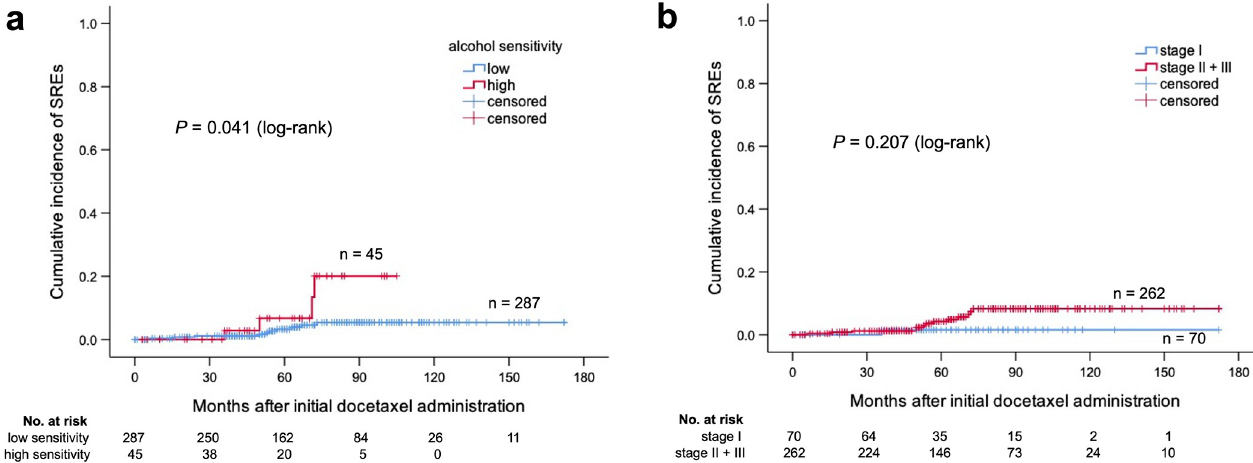
Fig 3. Cumulative incidence of SREs by alcohol sensitivity and clinical stage. (a) Cumulative incidence of SREs by alcohol sensitivity. (b) Cumulative incidence of SREs by clinical stage (stage I vs. stages II and III). The number below each figure is the number of patients at risk. SREs, skeletal-related events.